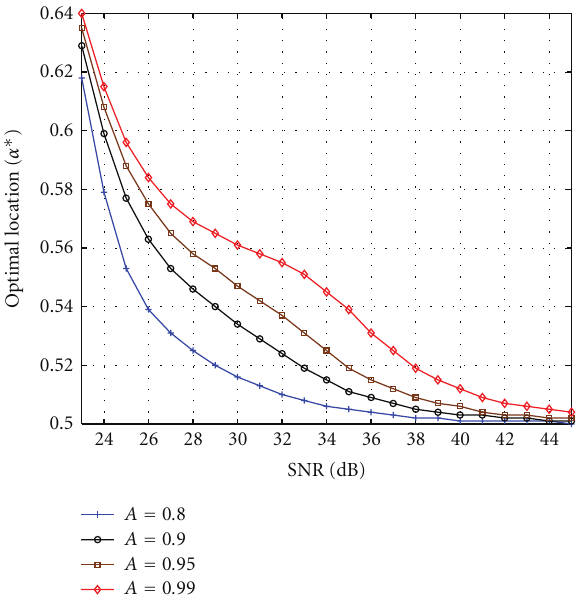
Figure 4: The total transmission energy used in di ff erent sensor networks (with the unit noise power) with Gaussian channels ( A = 0 . 9, β = 3 . 5, d =